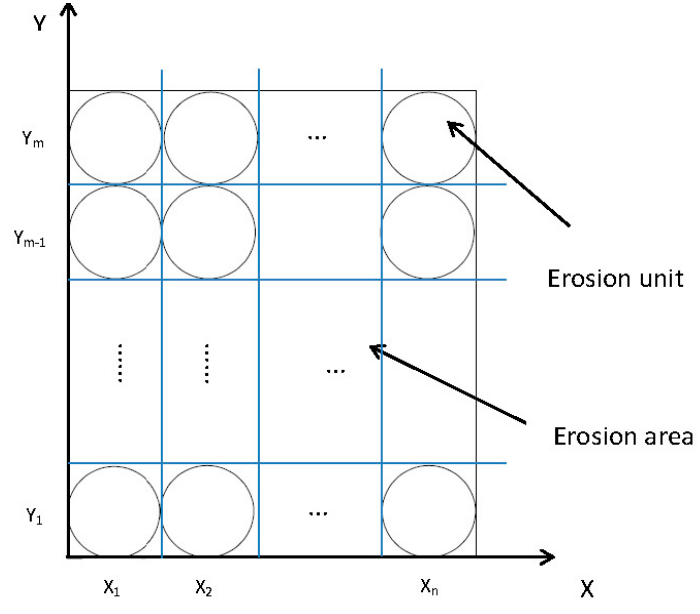
Figure 1. Hypothesised spatial distribution in slope erosion.